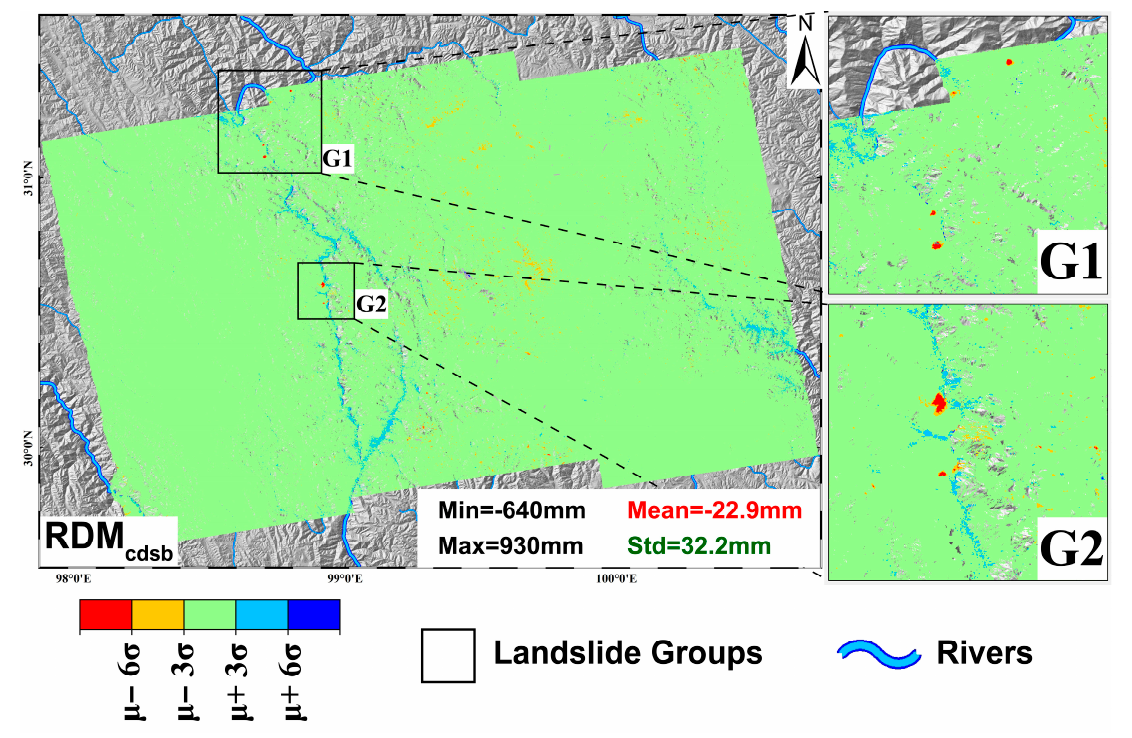
Figure 9. Annual velocity map obtained by SBAS.